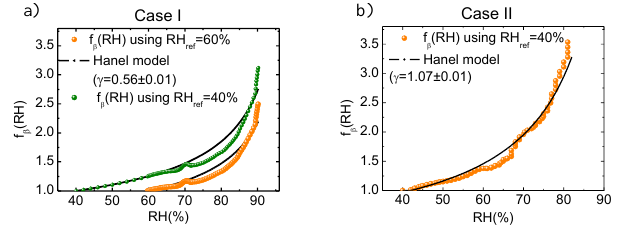
Figure 5. (a) f β (RH) retrieved on 22 July 2011 (Case I) from 20:30 to 21:00UTC for the height range between 1330 and 2330ma.s.l. (yellow dots for RH ref = 60% and green dots for RH ref = 40%). (b) f β (RH) retrieved on 22 July 2013 (Case II) from 20:00 to 20:30UTC for the layer corresponding to heights between 1300 and 2700ma.s.l. using RH ref =